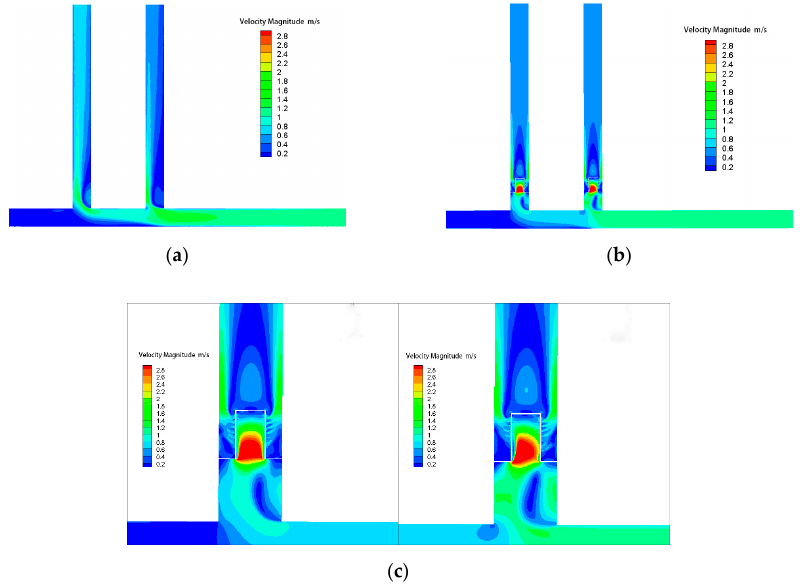
Figure 6. The velocity distribution of the branch at the temperature of 40 °C and a flow rate of 120 t/h. ( a ) velocity distribution of parallel pipelines without rectifier nozzles; ( b ) velocity distribution of parallel pipelines with rectifier nozzles; ( c ) velocity distribution near the rectifier nozzle. Water 2020 , 12 , x FOR PEER REVIEW